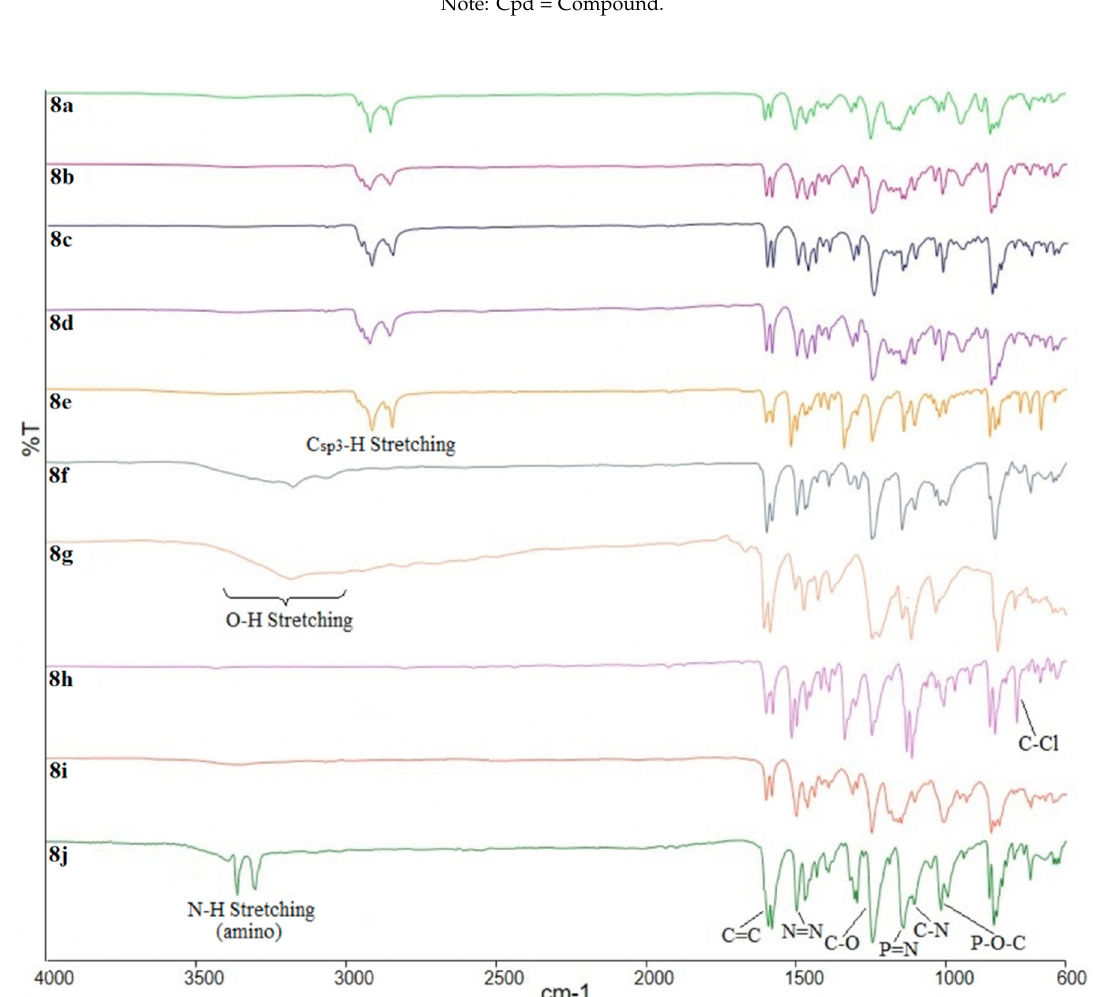
Figure 3. FTIR spectra overlay of compounds 8a–j (Series 2).